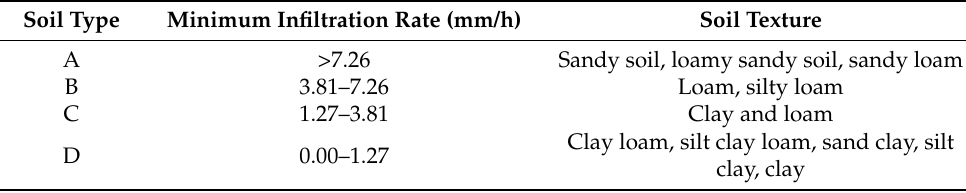
Table 2. Soil permeability